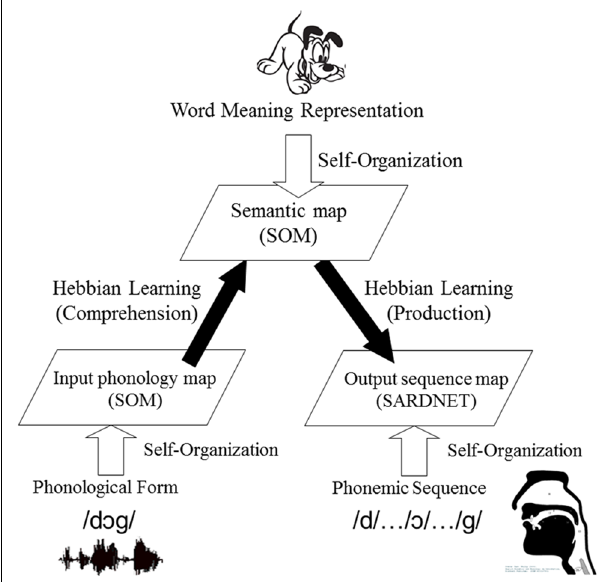
FIGURE 2 |A sketch of the DevLex-II model. See text for explanation of the architecture of the